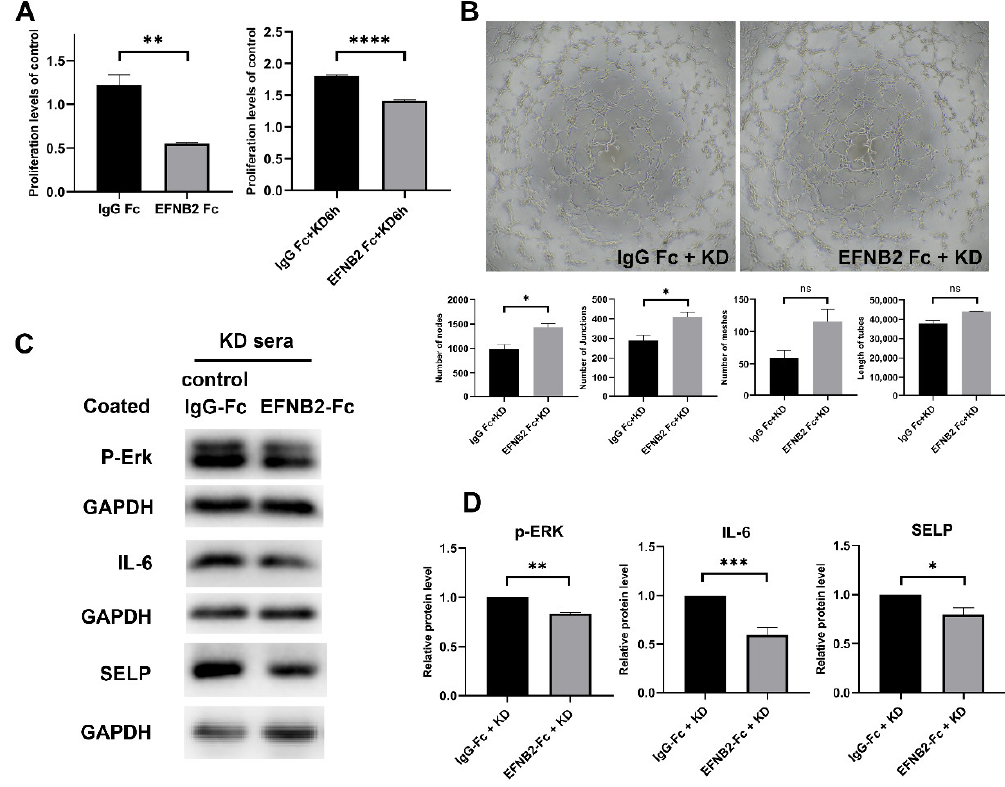
Figure 5. Effects of EFNB2-Fc on cell proliferation, angiogenesis ability, and inflammation. ( A ) HCAECs were seeded in plates precoated with EFNB2-Fc or IgG Fc and incubated for 24 h. The medium was then changed with 15% KD sera for six hours or not, and cell proliferation was de- tected by CCK-8. ( B ) HCAECs were seeded in plates precoated with EFNB2-Fc or IgG Fc, incubated for 24 h, changed medium with 15% KD sera for 6 h, and then plated on Matrigel. ( C , D ) HCAECs were seeded in plates precoated with EFNB2-Fc or IgG Fc, incubated for 24 h, and changed medium with 15% KD sera for 6 h. The protein levels of p-ERK, IL-6, and SELP were measured by